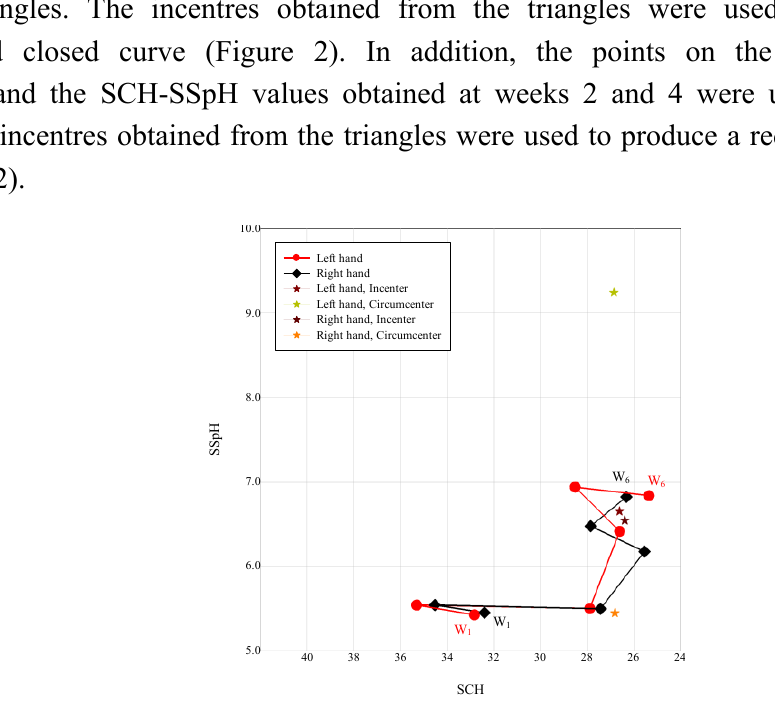
Figure 1. First measurement of the stratum corneum hydration (SCH)-skin surface pH (SSpH) relationship over six weeks ( N =